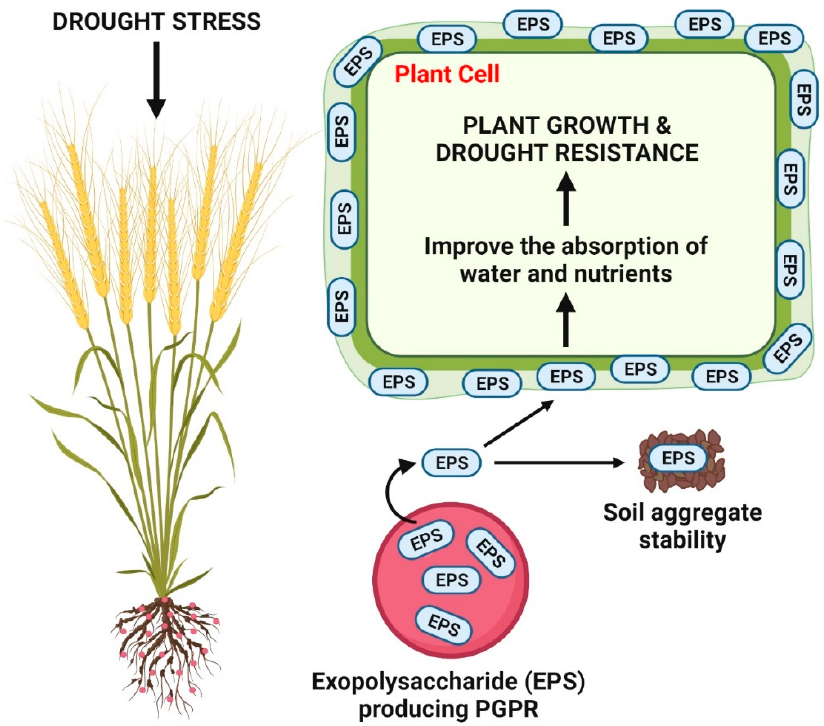
Figure 3. Exopolysaccharide producing PGPR-mediated alleviation of drought stress in plants.